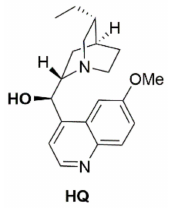
Figure 6. Structure of HQ